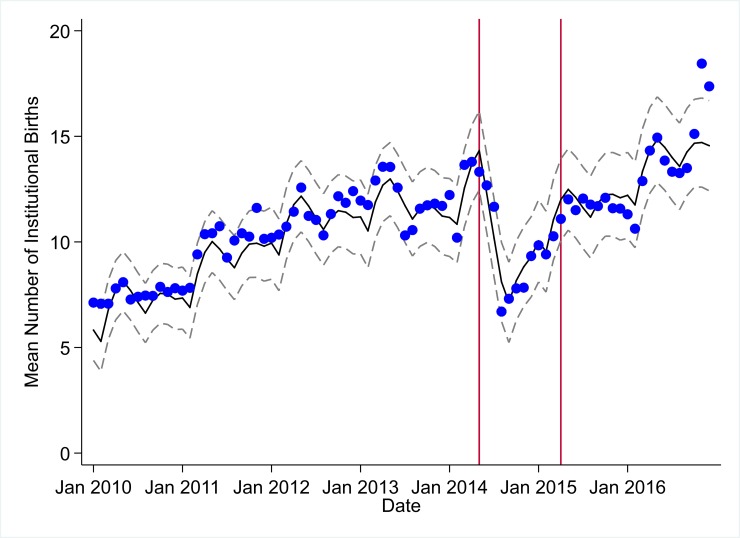
Mean trends and system losses due to Ebola virus disease (EVD) outbreak (June 2014–April 2015) for institutional births in a census of 379 clinics providing services in Liberia from 2010–2016, excluding Montserrado County.The black solid line represents the fitted mean from a linear mixed model using a segmented regression parameterization, random intercepts and slopes by facility, monthly indicator variables to adjust for seasonality, a fixed effect to adjust for clinic-level catchment area, and an AR(1) structure to account for autocorrelation in residual errors. Gray dashed lines are 95% confidence intervals around the fitted mean. Red lines are placed at the final month before the start (May 2014) and end (April 2015) of the EVD outbreak in Liberia.